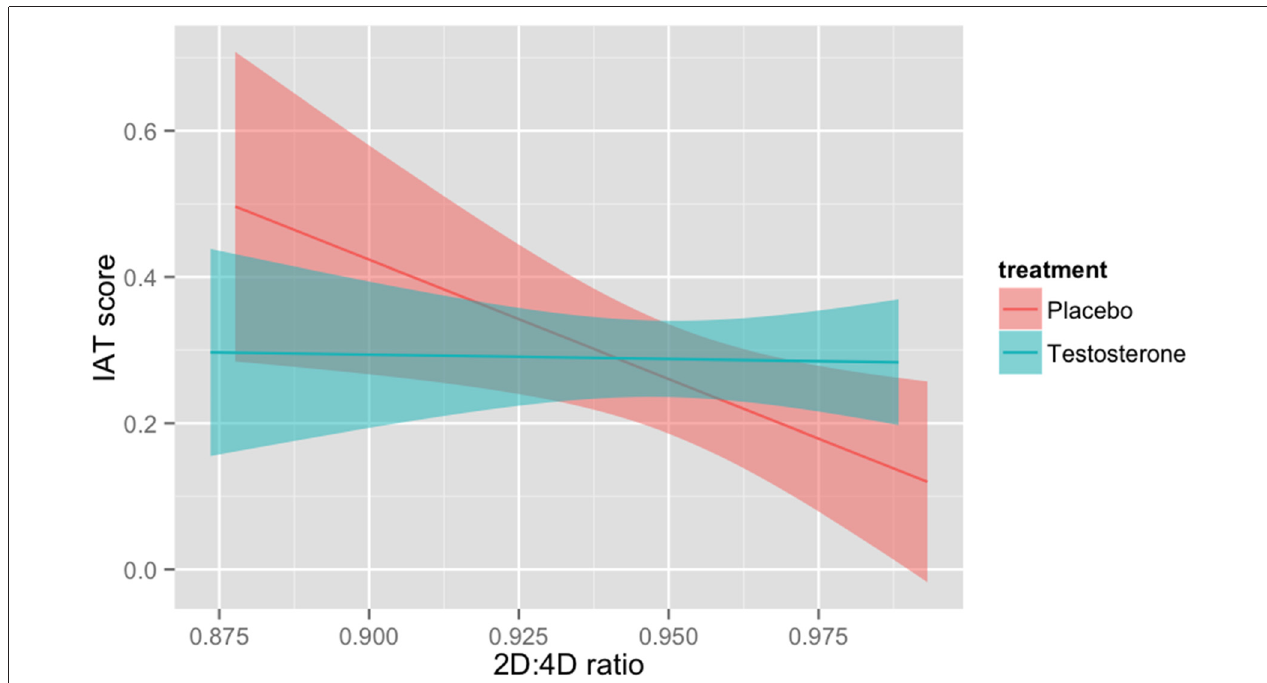
FIGURE 1 | Interactive effect of second-to-fourth digit ratio (2D:4D) and testosterone administration on implicit association test (IAT) score (log-transformed).